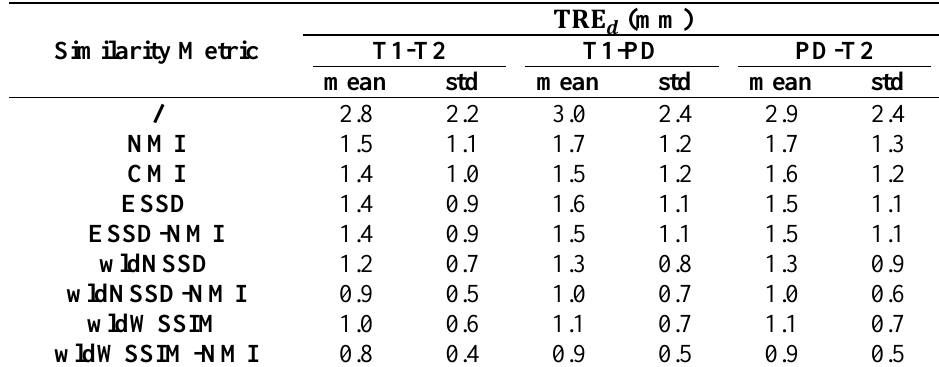
(in mm) for all the evaluated